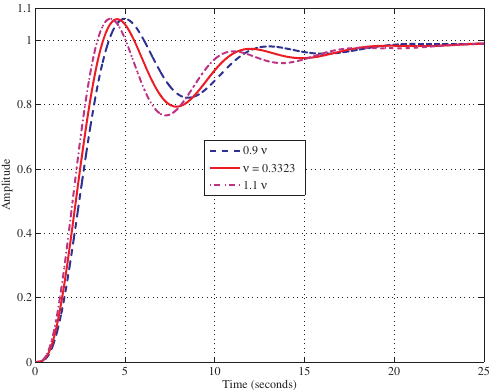
Figure 11. Unit step response in the first example for different fractional orders.